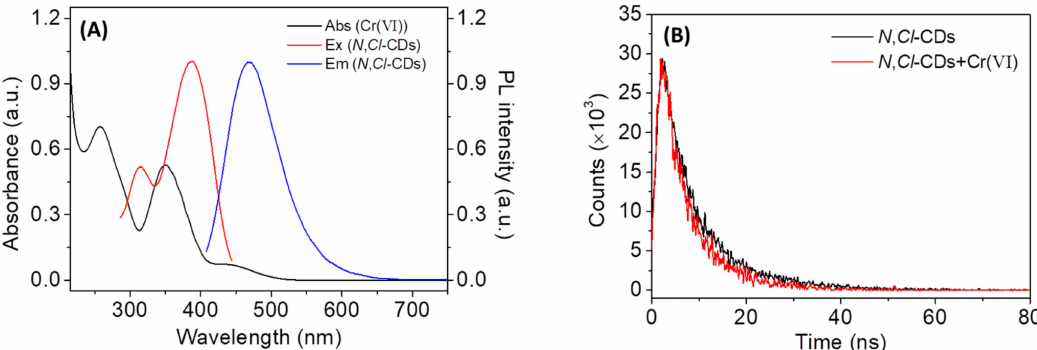
Figure 6. ( A ) The PL excitation (red line) and emission (blue line) spectra of N , Cl -CDs and UV-vis absorption spectrum of Cr(VI) (black line); ( B ) the fluorescence decay curves of N , Cl -CDs (1.25 mg/mL) in the absence and in the presence of 10 µ M